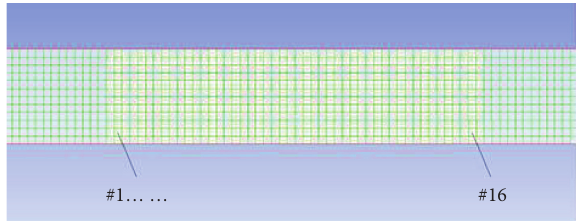
Figure 7: Computational domain and grids.